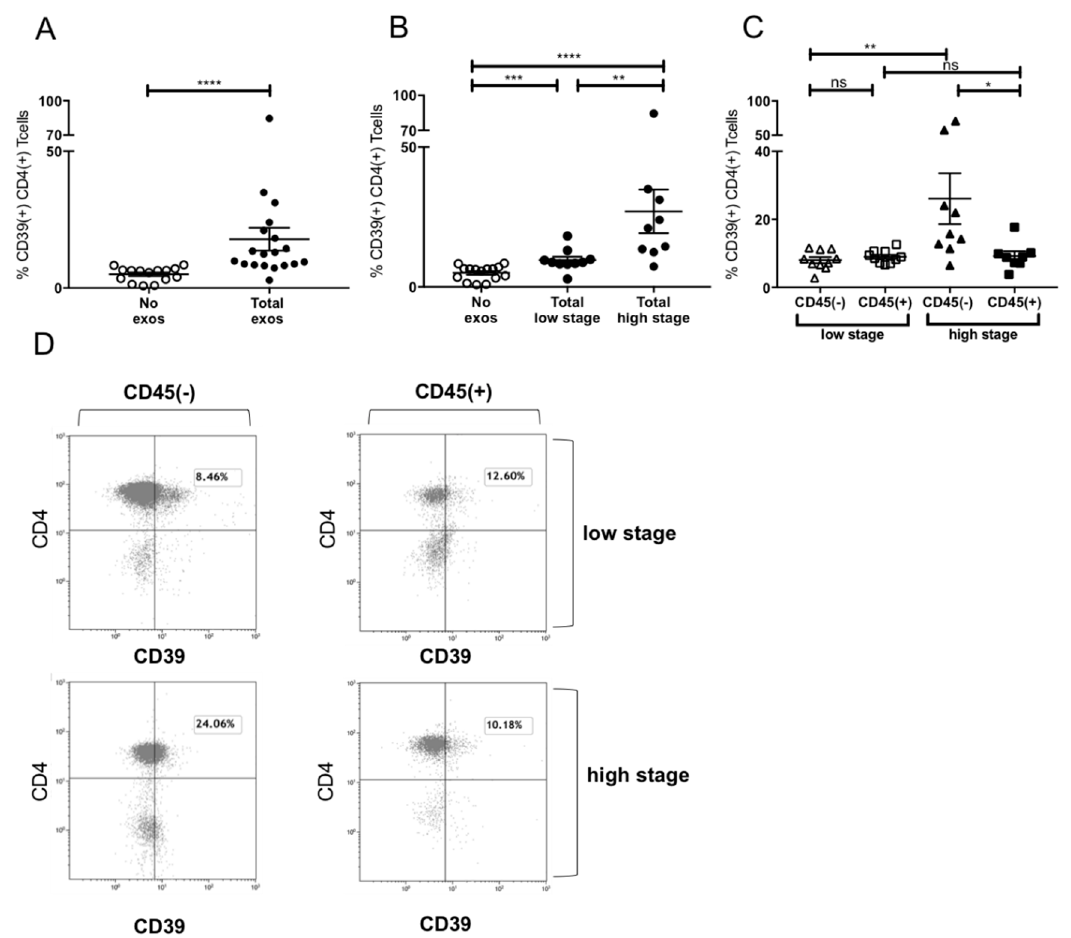
Figure 5. Induction of CD39+ T reg differentiation by plasma-derived exosomes. ( A ) Expression of CD39 after incubation with total exosome fraction of patients of all stages ( B ) Expression of CD39 after incubation with total exosomes of low stage vs. high stage patients. ( C ) Expression of CD39 after incubation with CD45( − ) and CD45(+) exosomes of low stage and high stage patients. Note that only incubation with CD45( − ) exosomes showed significant stage-dependent differences.; n = 18. p values were determined with Mann-Whitney test, with * p < 0.05, ** p < 0.005, **** p < 0.0001. Bars represent standard error of mean (SEM). ( D ) Representative flow cytometry plots depicting CD39 expression of CD4+ T cells after incubation with CD45( − ) (left) or CD45(+) (right) exosomes of UICC low stage (top) or high stage (bottom) patients.